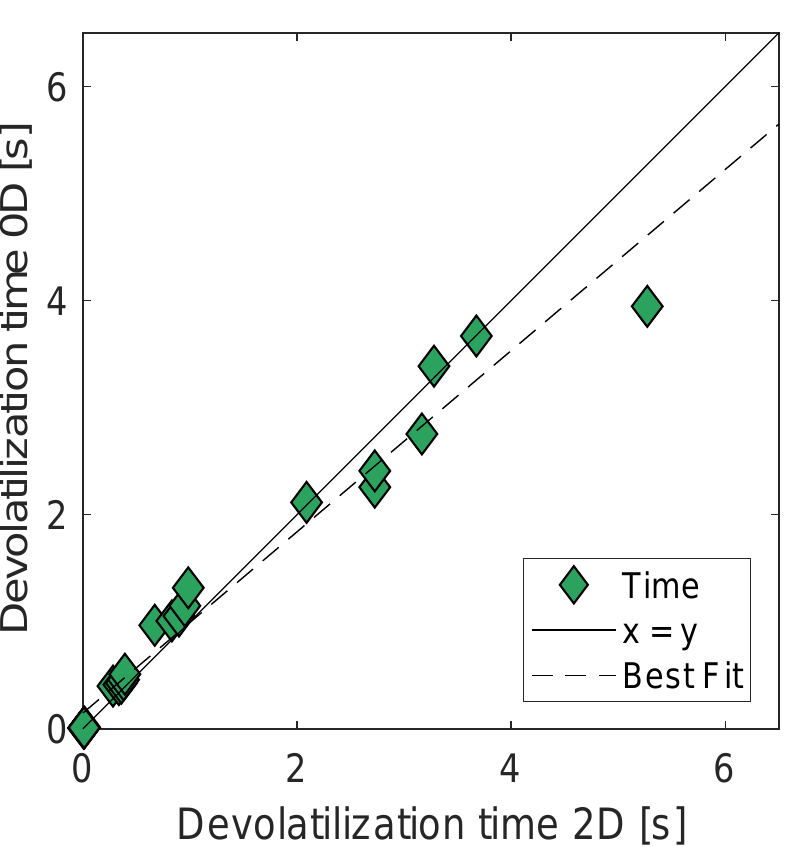
Figure 8. Comparison of the time predicted by the semi-2D model and the 0D model with the best fit linear regression r 2 = 0.97. Conditions for data points are listed in the Appendix